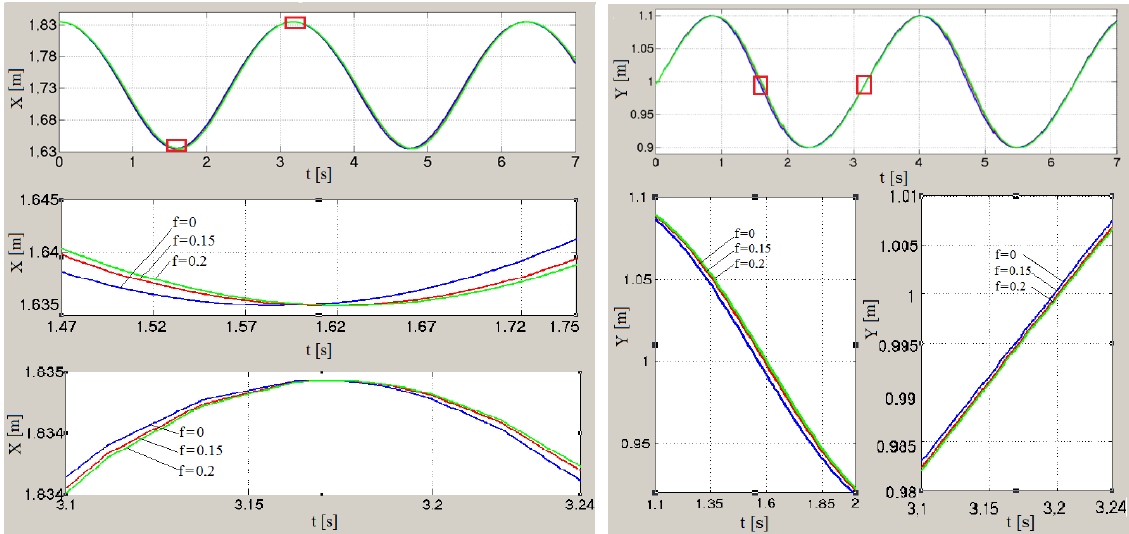
Figure 15. Graphs of coordinates X ( t ) and Y ( t ) of point C for different values of the coefficient of sliding friction f and for coefficient of rotational friction k = 0 and for load mass M = 70kg.